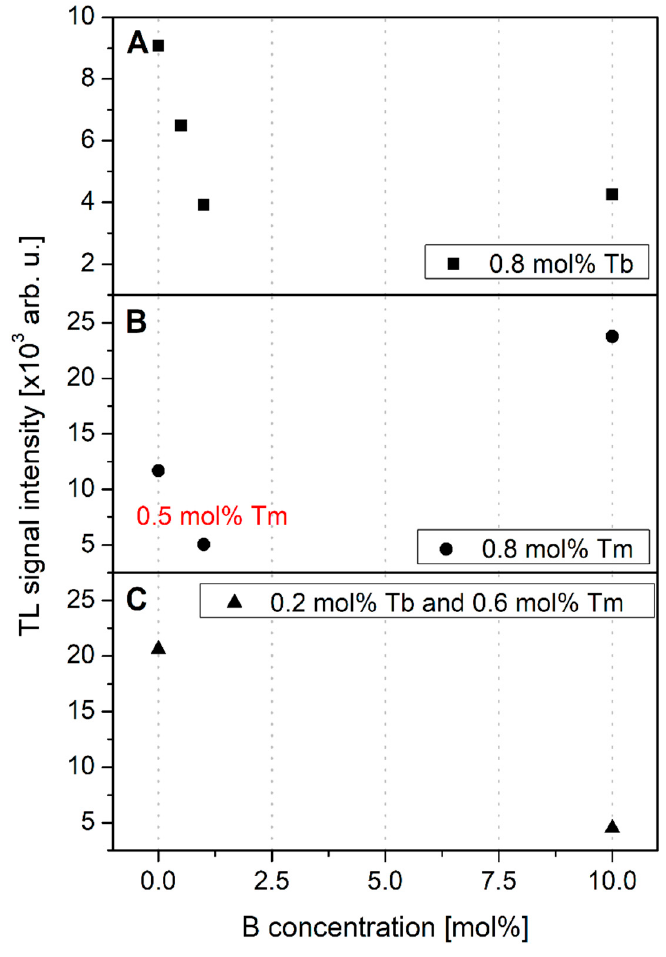
Figure 8. Thermoluminescence signal intensity as the function of B ions concentration in 0.8 mol% Tb-doped crystals (panel A ), 0.8 mol% Tm-doped crystals (panel B ) and 0.2 mol% Tb and 0.6 mol% Tm-doped crystals (panel C ). Note that in most cases the error bars are smaller than the size of measured data-points.